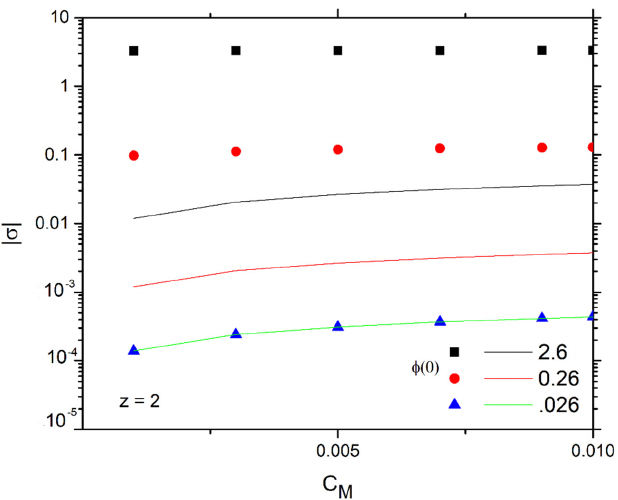
) as a function of C ( mol ) for z = 2 ions and various ϕ ( 0 )( V ) M m 2 m 3